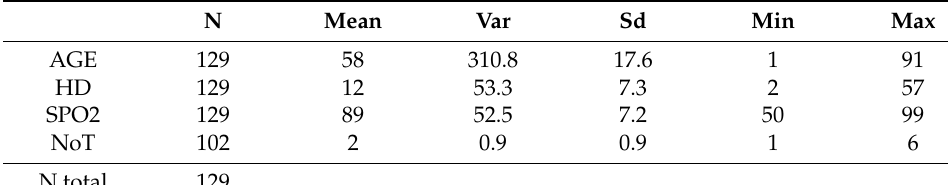
Table 3. Second sample of COVID-19 patients from the second wave of